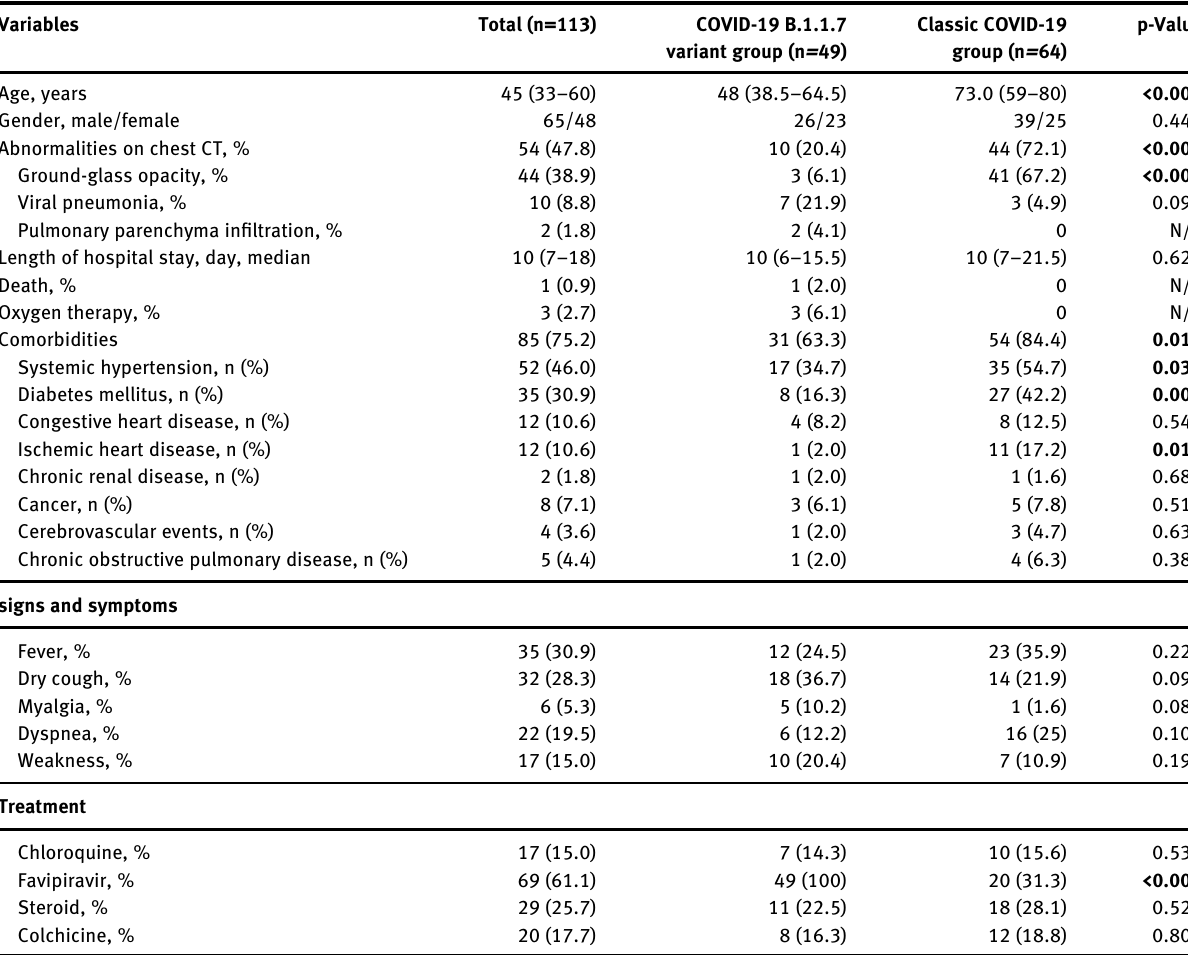
Table  : Demographic characteristics of the COVID-  groups.